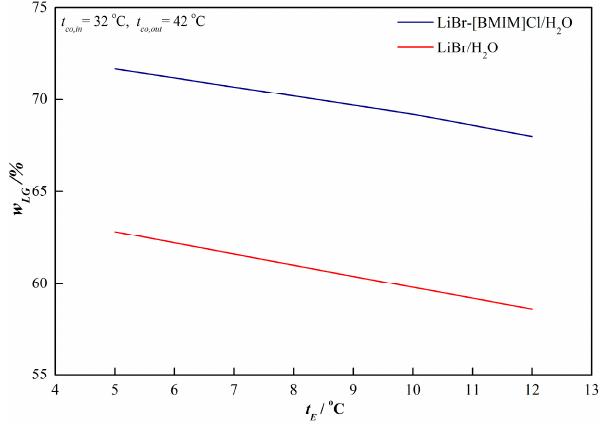
Figure 5. Variations of w LG with the evaporation temperature t E .